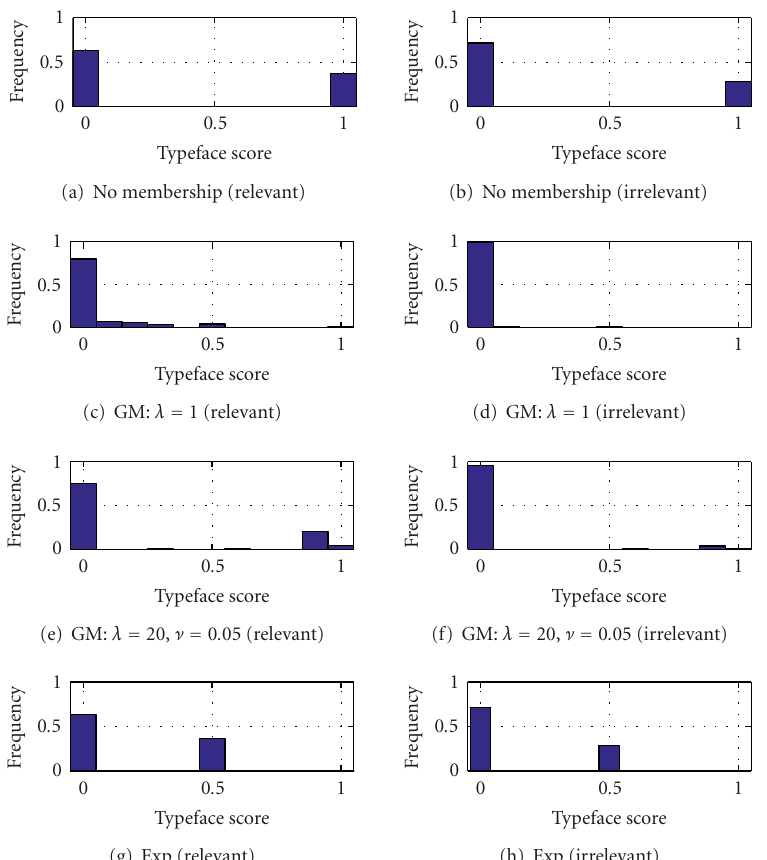
Figure 11: Typeface score distribution using no membership, generalized, and exponential memberships for user-labeled relevant and irrelevant